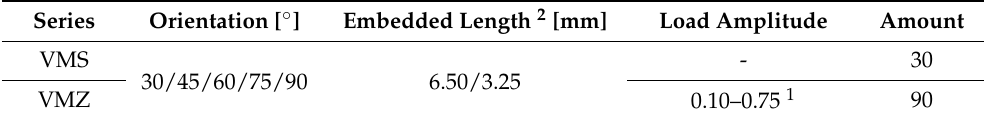
Table 1. Test program of pullout tests.